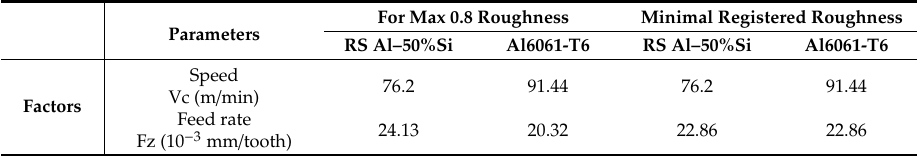
Table 4. Optimal parameters for surface roughness for a max value for 0.8 µ